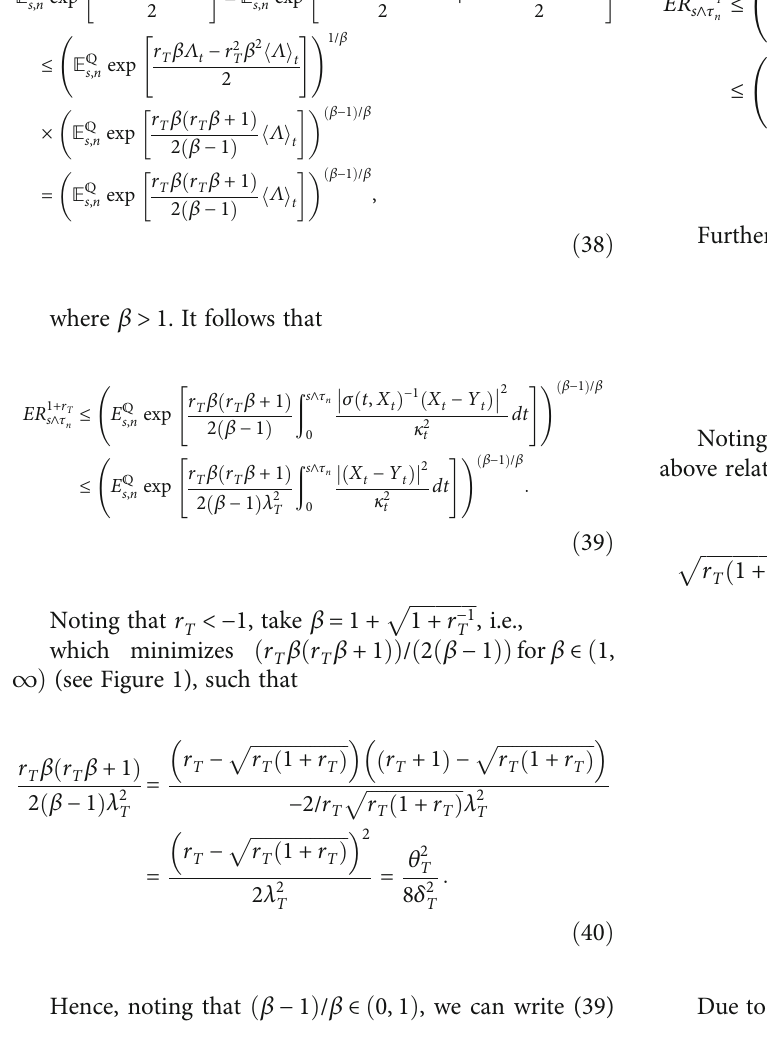
ffiffiffiffiffiffiffiffiffiffiffiffiffiffiffiffiffiffiffiffi 1 + r r T